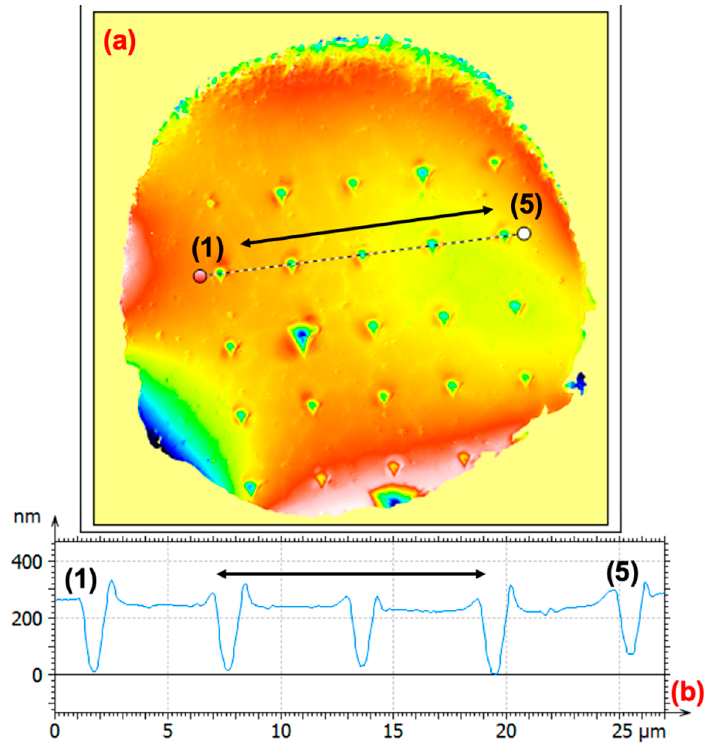
Figure 7. Continued confocal analysis of pile-up associated with nano-indented Al 6061 powder. ( a ) presents five indentation imprints and their respective degree of pile-up that are associated with